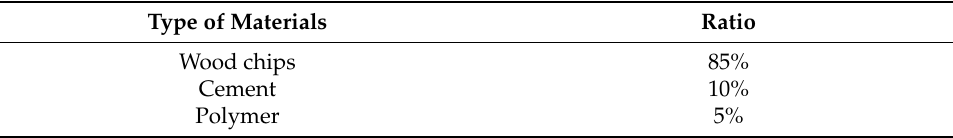
Table 1. Composition of concrete block with wood